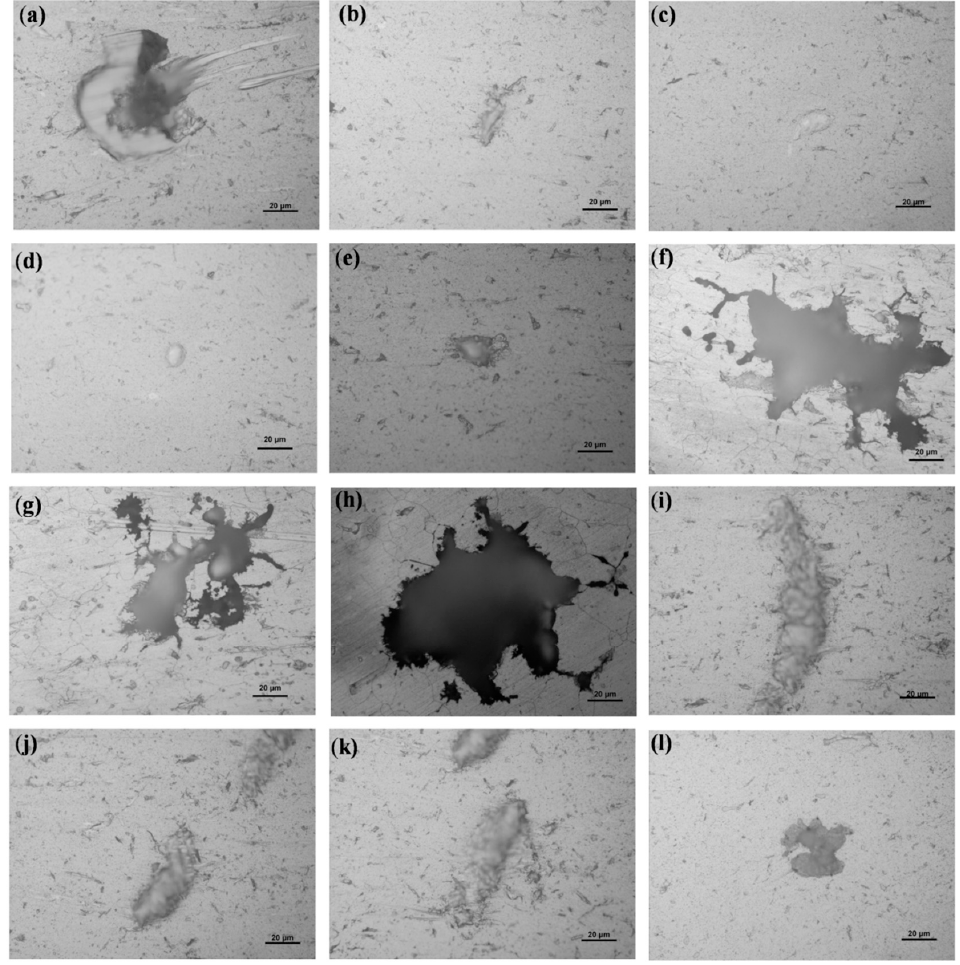
Figure 3. Optical morphologies of pits observed on Sample-H after constant immersion. ( a – l ) are the selected pitting points from A to K listed in Table 2, respectively.